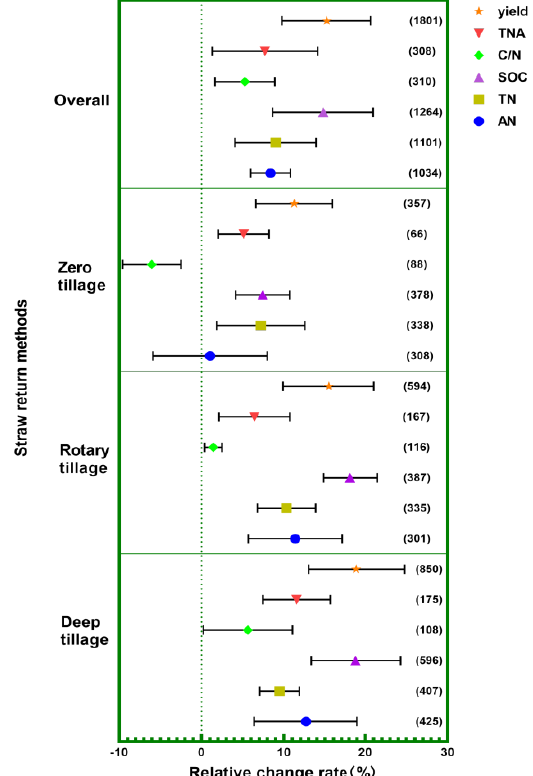
Figure 7. Relative change rate for different straw return methods. Description of symbols: AN, soil alkali−hydrolysable nitrogen; TN, soil total nitrogen; SOC, soil organic matter; C:N, soil carbon to nitrogen ratio; and TNA, total N accumulation. Numbers in parentheses represent the effect value (lnR).